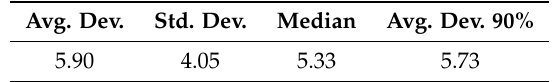
Table 4. Average deviation (as %) of the prediction of the elongation at break.